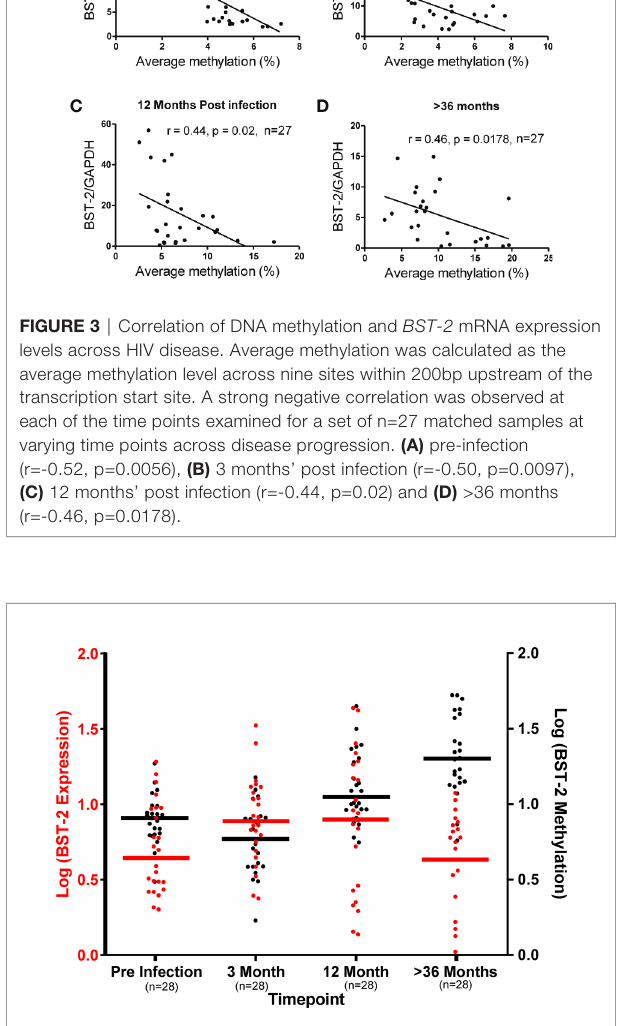
FIGURE 4 | DNA methylation levels dictate BST-2 mRNA levels during HIV disease. Baseline levels of 27 matched samples at varying time points across disease progression show at the pre-infection higher methylation (Black) and low BST-2 expression (Red), while at acute infection (3-month post infection) methylation and expression levels are at similar level, due to IFN induction. The BST-2 expression and methylation levels invert at 12 months ’ post infection. The most dramatic difference is observed at the >36 months timepoint, these individuals are at a chronic phase of infection, at this time point we observe the lowest expression and highest